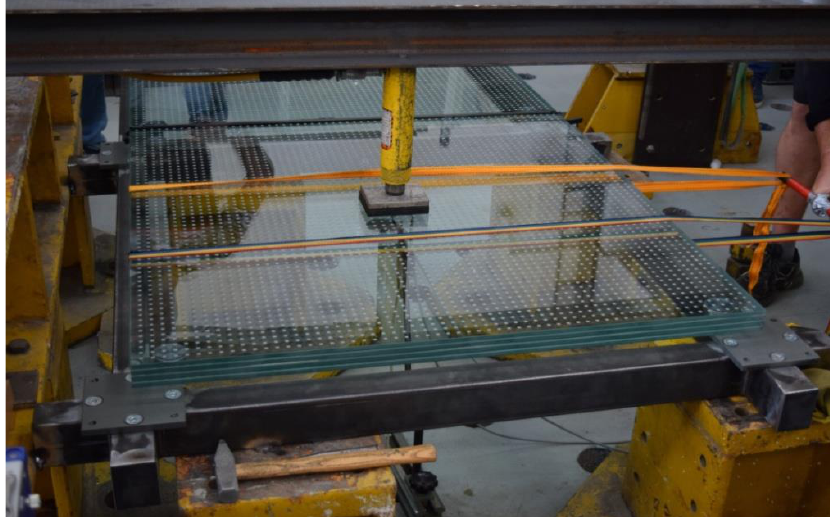
Fig. 5 Photo of the test specimen (applied vertical and horizontal load).